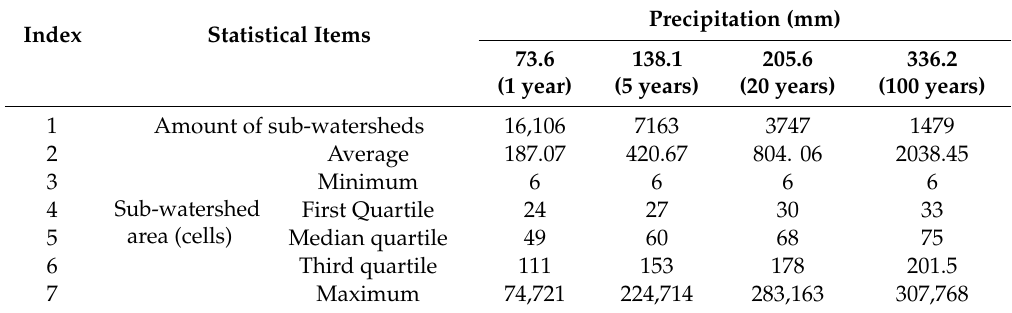
Table 4. Statistical information of four kinds of watershed delimitations derived by the corresponding design rainfall precipitations.